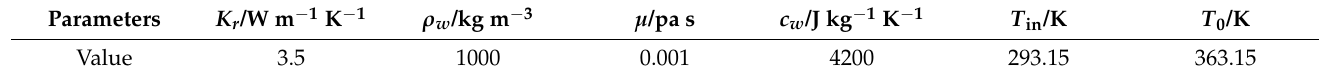
Table 1. The used parameters for heat transport modeling.